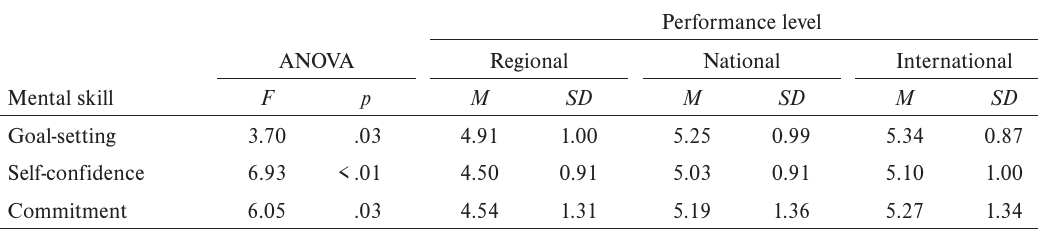
Results of ANOVA and values of mental skills divided according to athletes’ performance levels